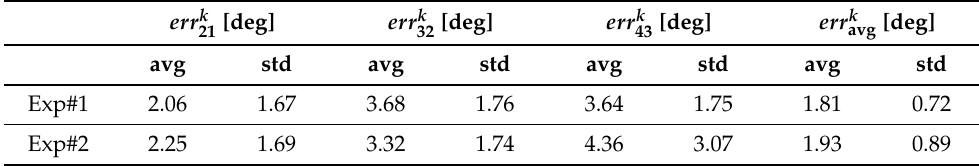
Table 2. Statistic indexes on the AoA estimation made without calibration.